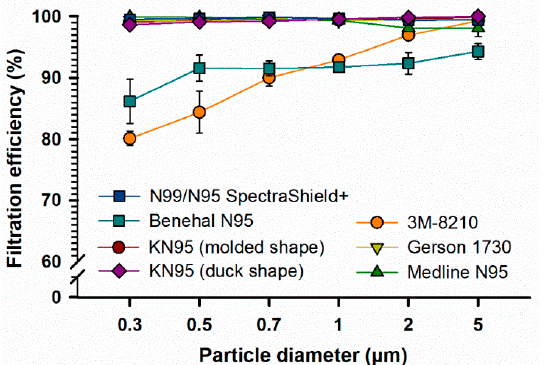
Figure 2. Filtration efficiency (FE) of different types of FFRs. Seven types of FFRs were applied to FE evaluation for different particle sizes (0.3–5 µm) using AeroTrak particle counter; KN95 (moulded shape, n = 10), 3M-1820 (n = 10), Gerson-1730 (n = 5), Medline (n = 5), Benehal (n = 5), N99/N95 SpectraShield Plus (n = 5), and KN95 (duck shape, n = 5) masks. Symbols represent the mean, and error bars indicate the standard error. Statistically, an overall significant difference ( p = 0.001) was observed between the median FE values between the FFRs, with a p -value of 0.001. Pairwise comparison: 3M-N95 vs. N99/N95 SpectraShield: p < 0.05; Benehal-N95 vs. N99/N95 SpectraShield: p < 0.05; no other pairwise comparison significant differences were observed. Raw data are listed in Supplementary Materials 3.